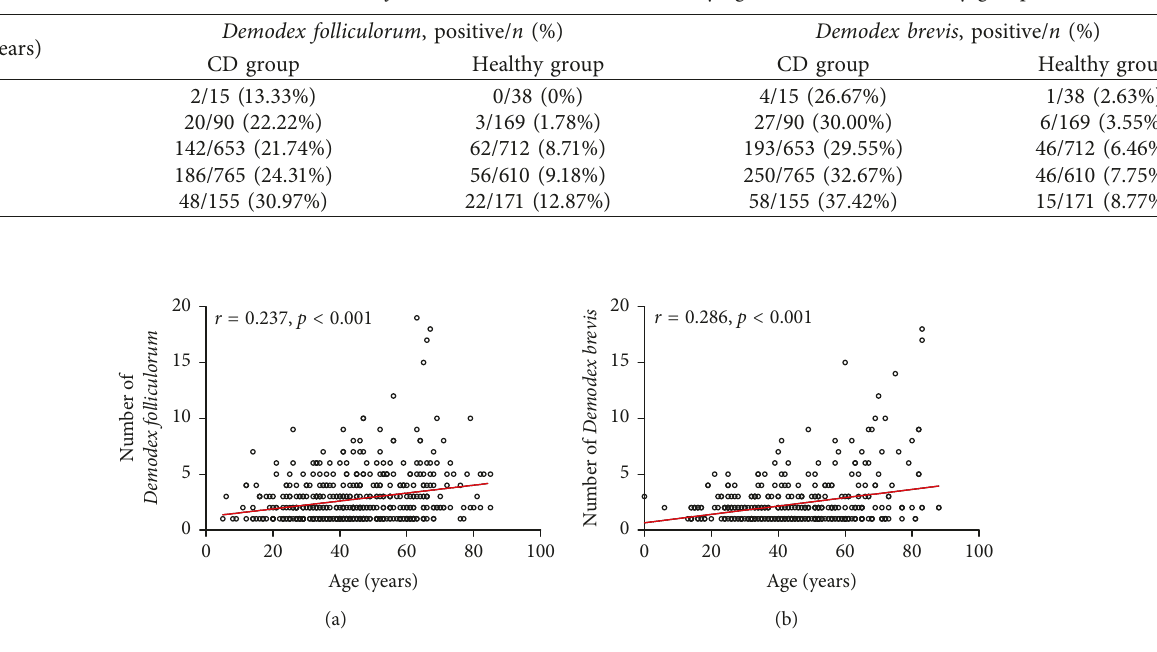
Figure 3: The average number of Demodex folliculorum (a) and Demodex brevis (b) are significantly correlated with increasing age, from children to older